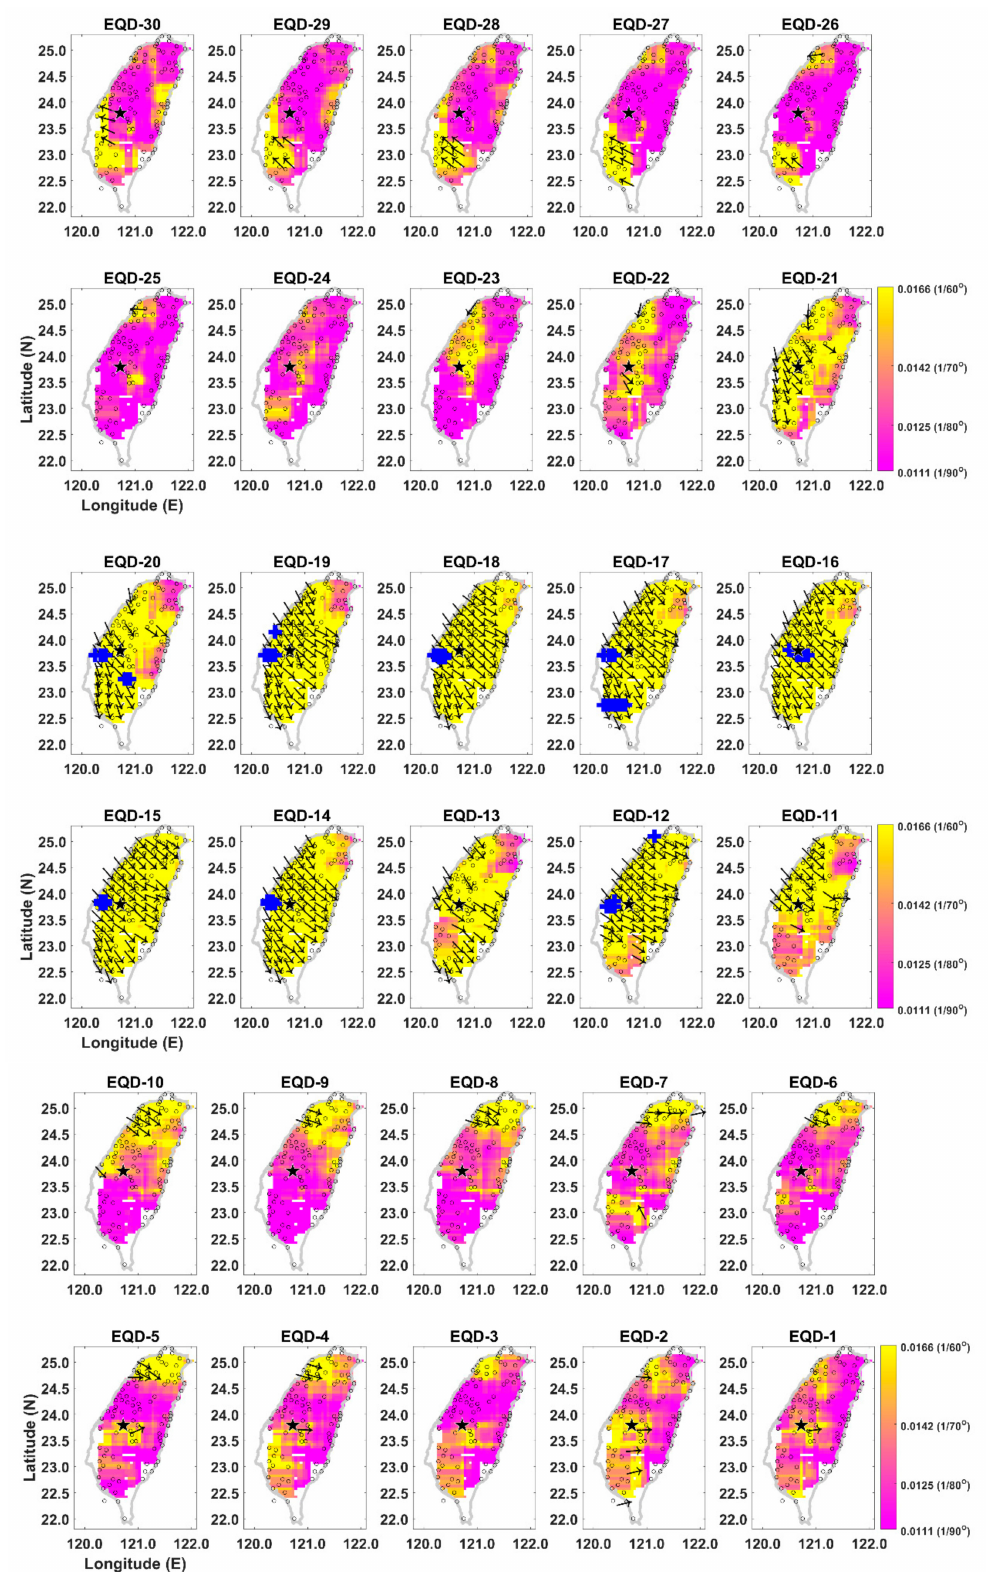
Figure 5. Maps of θ w ’ from 30 to 1 days before the earthquake day (EQD) in EQ28. The largest black star is the CWB-published epicenter of the EQ28. The blue crosses depict locations of the upper 0.5% θ w ’ , indicating possible epicenters before EQ28 occurred. The pink and yellow colors denote areas of small (~0.011) and large (~0.02) θ w ’ , respectively. Black arrows show the direction of surface